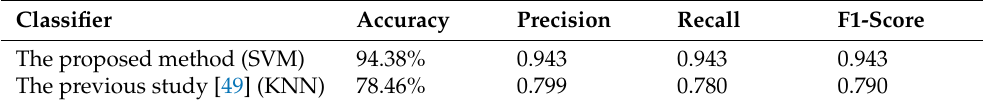
Table 32. Comparison results of the proposed ML models with a previous study .